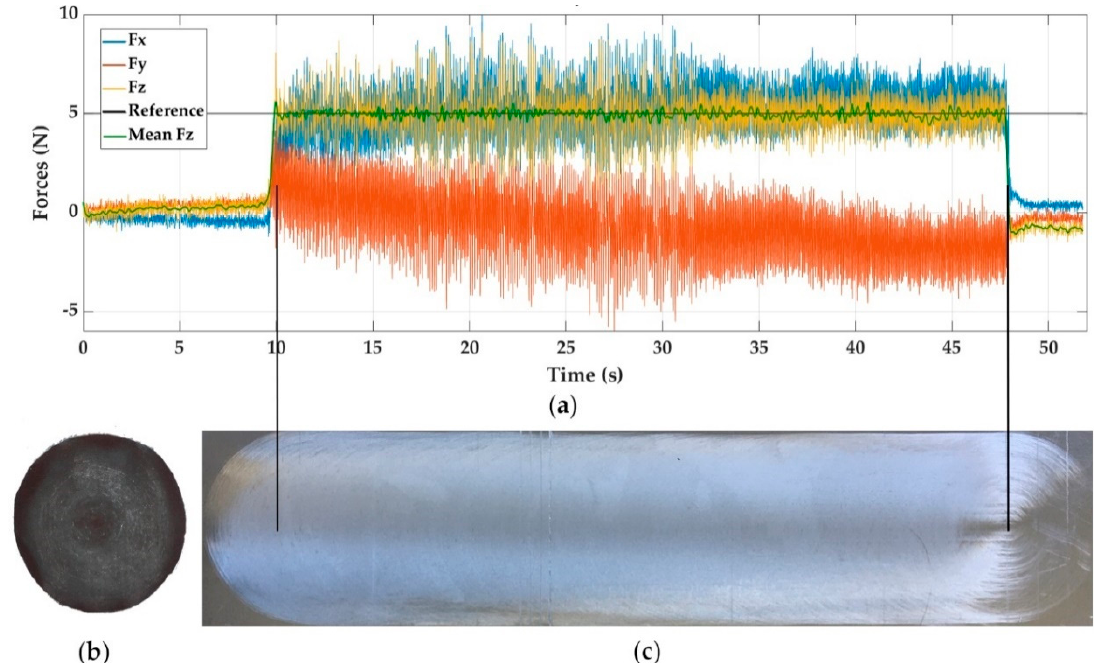
Figure 5. Experiment E2, sanding aluminium with P+FF control and reference force of 5 N. ( a ) Force response, ( b ) sandpaper aspect, and ( c ) visual surface finish.